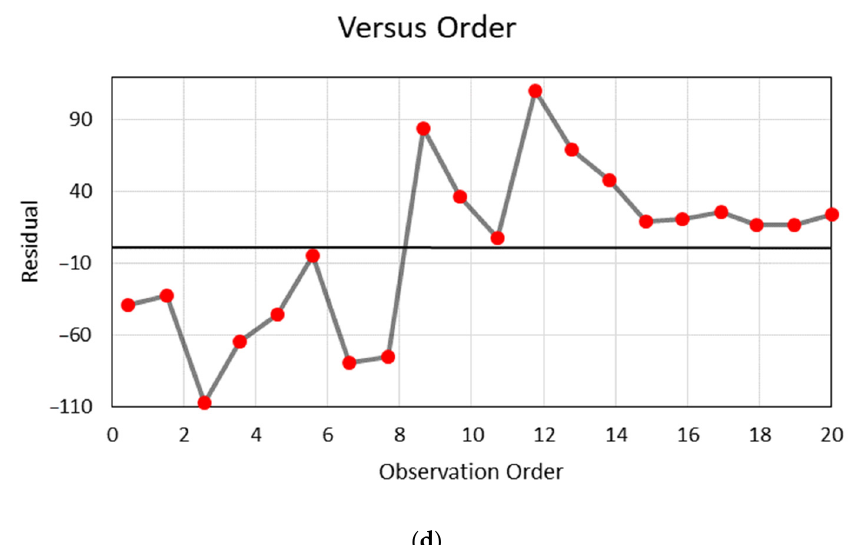
Figure 5. The residual diagrams related to the final COD after the water treatment process. ( a ) Normal probability plot. ( b ) Versus Fits plot. ( c ) Histogram plot ( d ) Versus order plot.